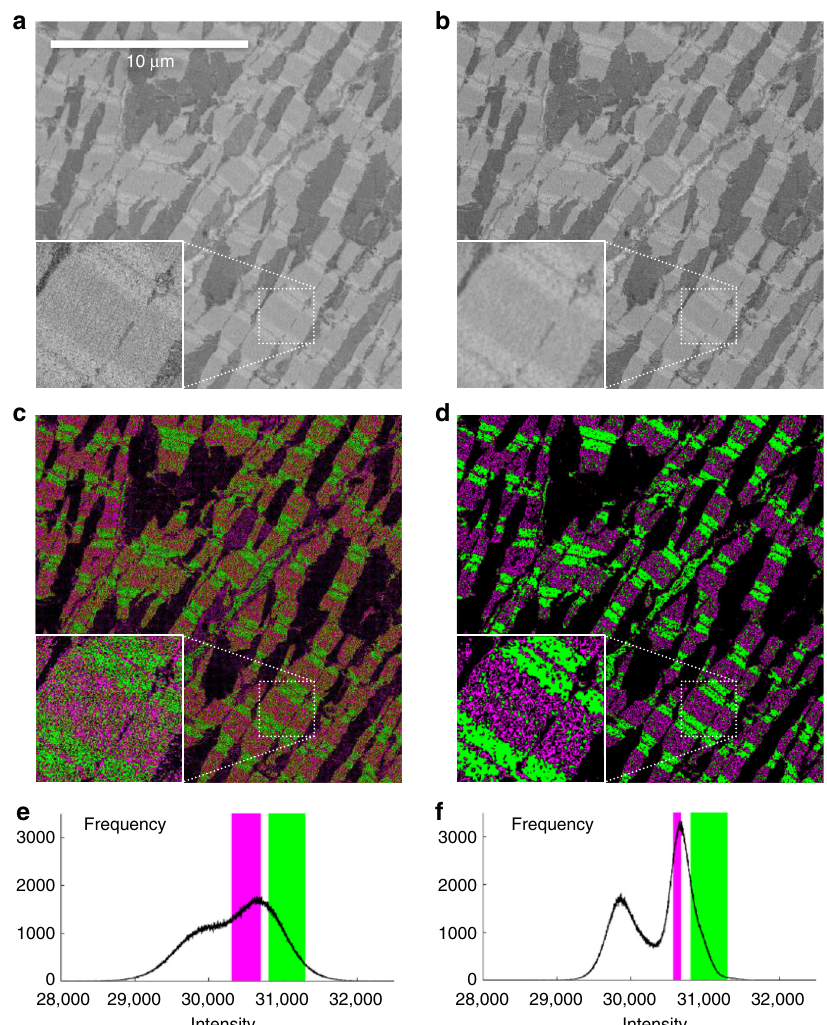
Fig. 4 In fl uence of denoising on thresholding segmentation of A/I-bands in mouse heart tissue SBF-SEM data. a One image of an SBF-SEM datastack is shown. The inset shows a zoom in the region indicated by the box. b The same image is shown after applying denoising. For visualization, thresholding was applied for two ranges of intensity values and a magenta mask was used to indicate A-bands, a green mask to indicate I-bands. c , d show the masks for the raw and denoised data, respectively. e , f show the intensity histograms that correspond to images ( a ) and ( b ), with indication in magenta and green of the threshold values that were used to generate images ( c ) and ( d